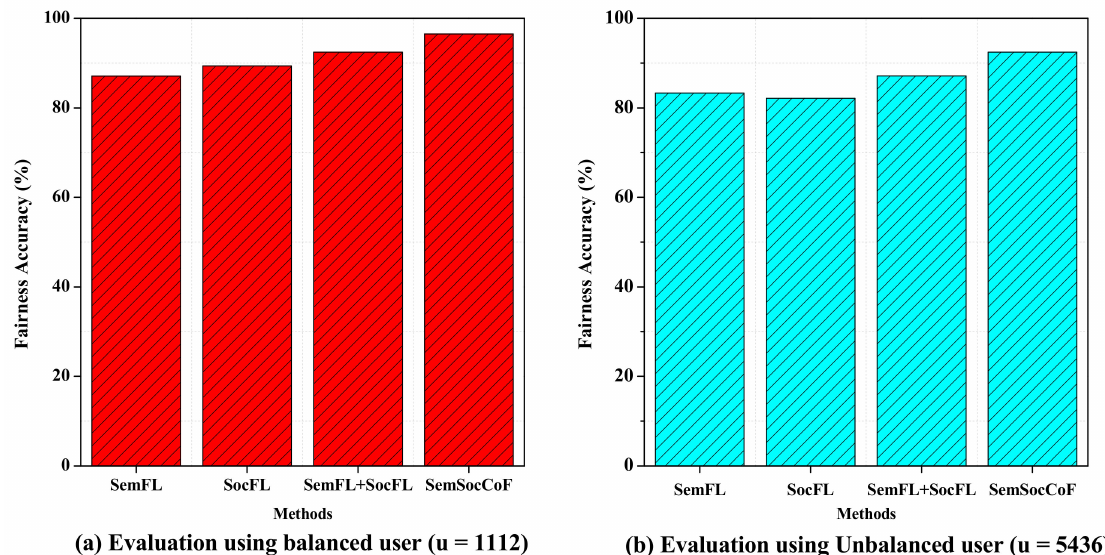
Figure 6. Fairness